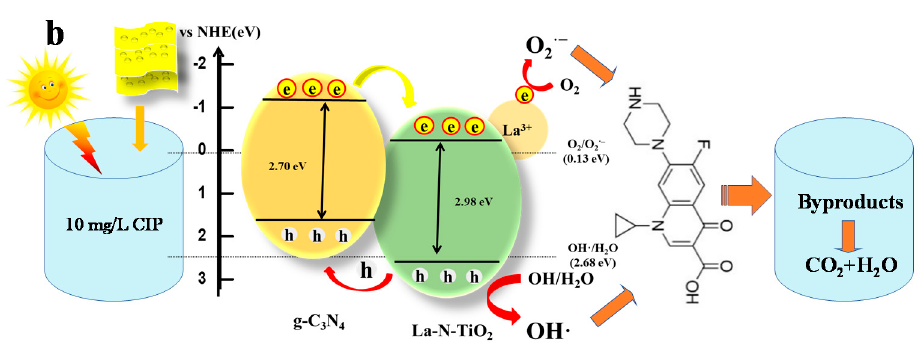
Scheme 1. ( a ) Photocatalytic activity of CN/La-N-TiO 2 toward CIP degradation in the presence of different scavengers and ( b ) schematic diagram for photocatalytic removal CIP mechanism by CN/La-N-TiO 2 photocatalyst under simulated solar light irradiation.